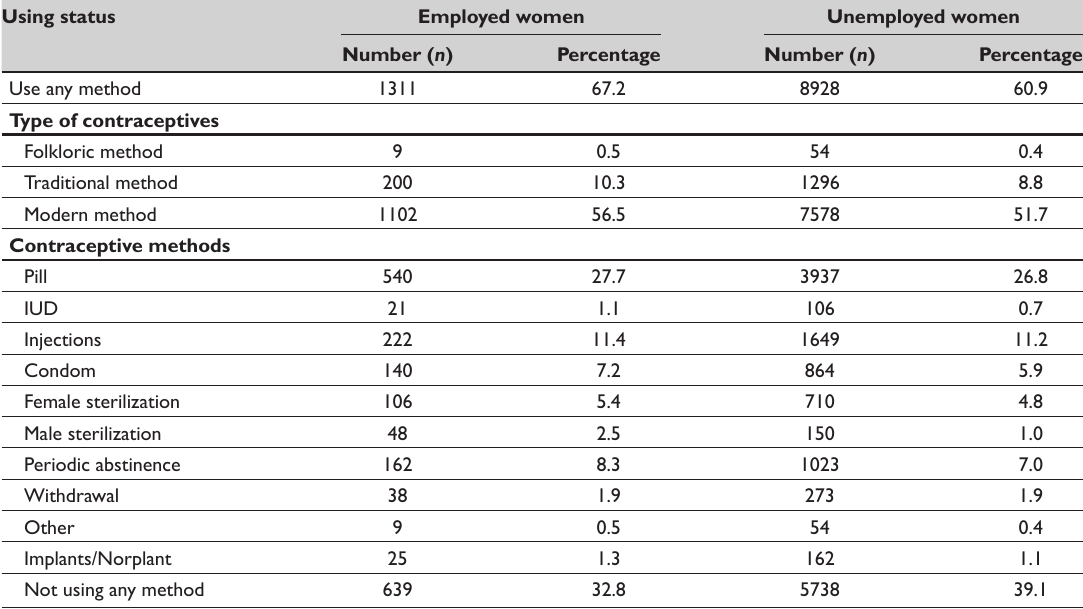
Table 1: Distribution of employed and unemployed women according to their current contraceptive use status Using